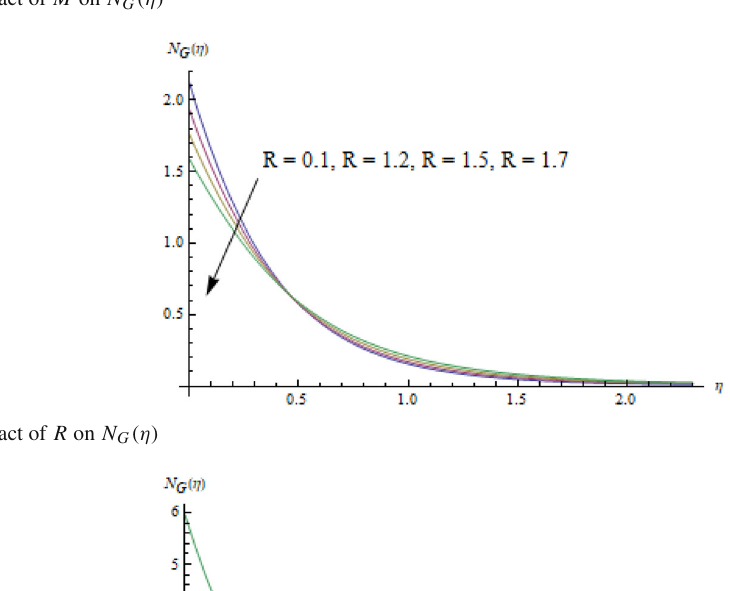
Fig. 34 Impact of M on N G (η)